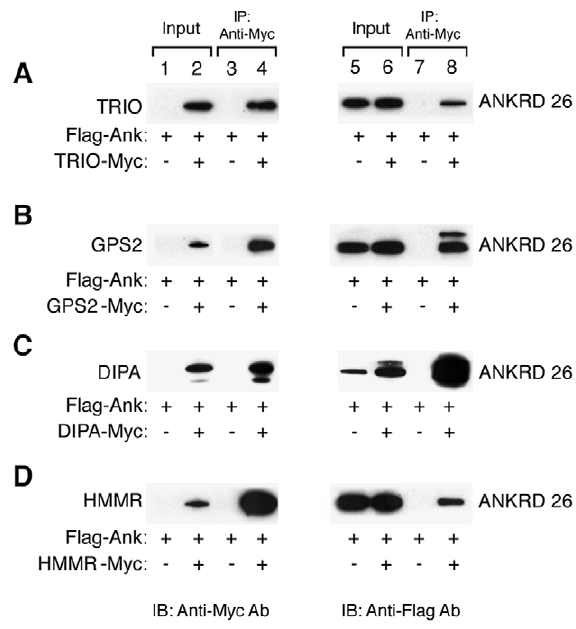
Figure 2. Protein interactions of ANKRD26 with TRIO, GPS2, DIPA and HMMR. A ) Immunoblot of whole cell lysates (input; lanes 1– 2 and 5–6) and IP (lanes 3–4 and 7–8) from 293/T cells over-expressing Flag-ANKRD26-C (lanes 1–8) and TRIO-Myc (lanes 2, 4, 6 and 8). B ) Immunoblot of whole cell lysates (input; lanes 1–2 and 5–6) and IP (lanes 3–4 and 7–8) from 293/T cells over-expressing Flag-ANKRD26-C (lanes 1–8) and GPS2-Myc (lanes 2, 4, 6 and 8). C ) Immunoblot of whole cell lysates (input; lanes 1–2 and 5–6) and IP (lanes 3–4 and 7–8) from 293/T cells over-expressing Flag-ANKRD26-C (lanes 1–8) and DIPA-Myc (lanes 2, 4, 6 and 8). D ) Immunoblot of whole cell lysates (input; lanes 1– 2 and 5–6) and IP (lanes 3–4 and 7–8) from 293/T cells over-expressing Flag-ANKRD26-C (lanes 1–8) and HMMR-Myc (lanes 2, 4, 6 and 8). IP were performed using the anti-Myc antibody as described in Methods. Left blots were probed with anti-Myc antibody, while right blots were striped and then probed with anti-Flag antibody.